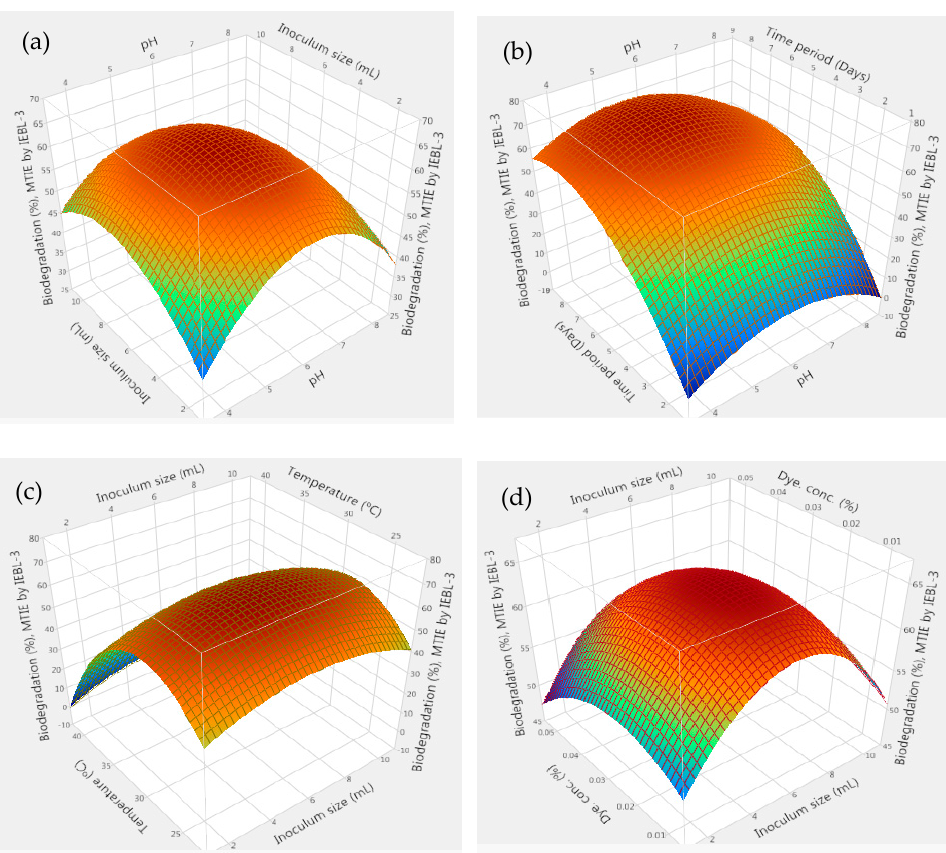
Figure 1. The 3D response surface graphs of interaction between parameters during the bio ‐ degradation of MT industrial effluent by P. betulinus IEBL ‐ 3; there is positive interaction be ‐ tween ( a )—pH and size of inoculum ( b )—pH and time ( c )—size of inoculum and temp. ( d )—size of inoculum and dye conc. ( e )—temp. and dye conc. ( f )—statistical analysis ( ⃰ indicate significance of value). There was almost 72.09 ± 1.2% biodegradation of FS industrial effluent, and the most suitable conditions were pH 5.6, time of 08 days, size of inoculum 6.60 mL, temp. 27.09 °C and dye concentration 0.038%. The biodegradation obtained was the combinatorial effect of all of the five parameters under study, indicated by the 3D graphs obtained from the results (Figure 2). There was a significant effect on all the parameters on the biodegrada ‐